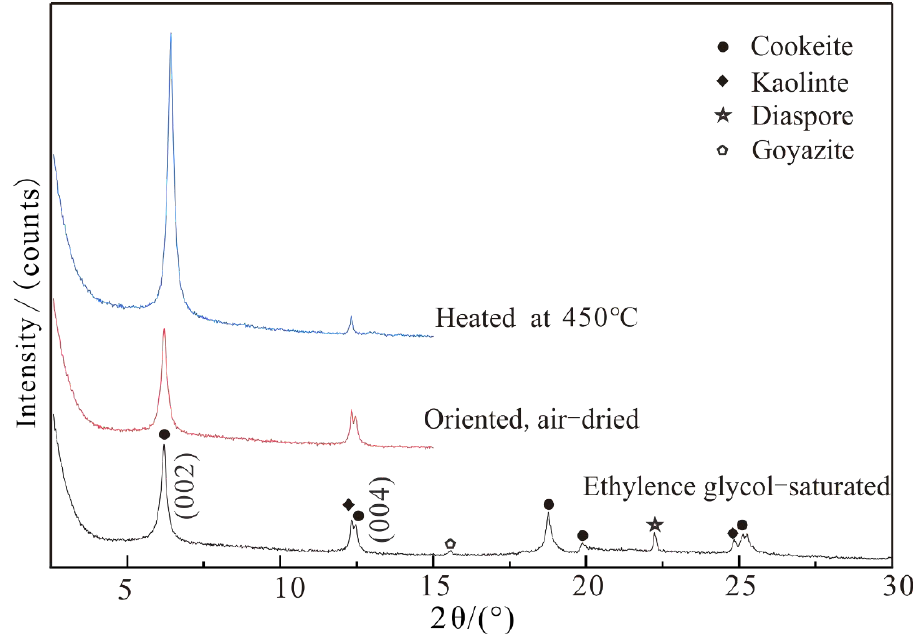
Figure 7. Oriented-aggregate XRD patterns of the sample Y1 obtained from air-dried, glycol-saturated, and heated (450 °C for 2.5 h) < 2 μm fractions.